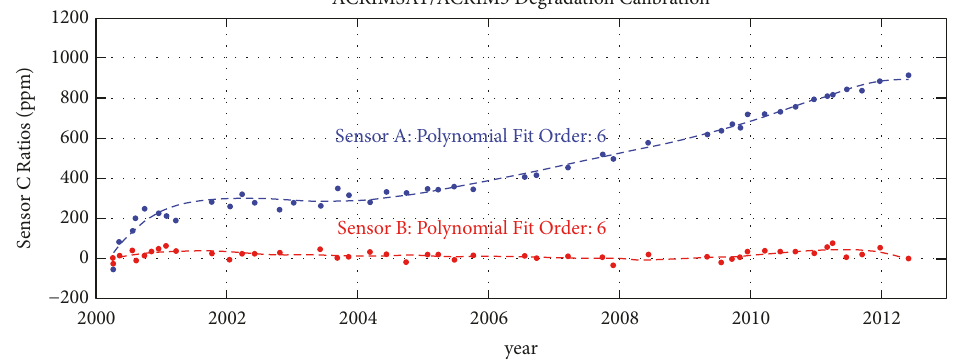
Figure 3: Degradation of the ACRIMSAT/ACRIM3 sensors over the mission.